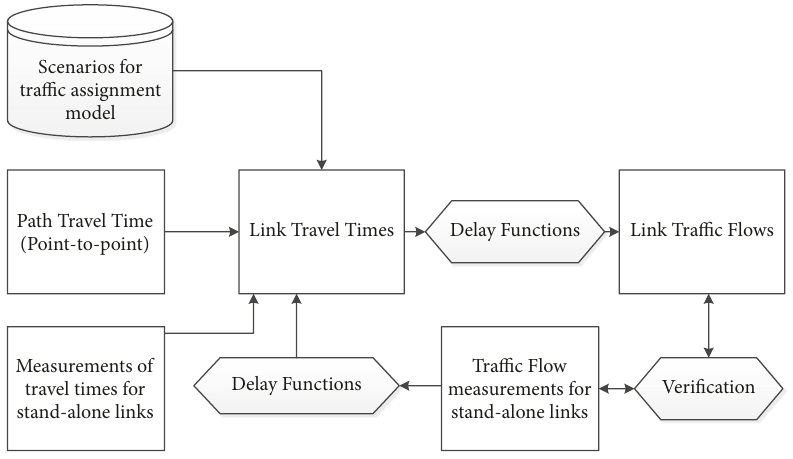
Figure 6: Traffic flow estimation procedure from path travel